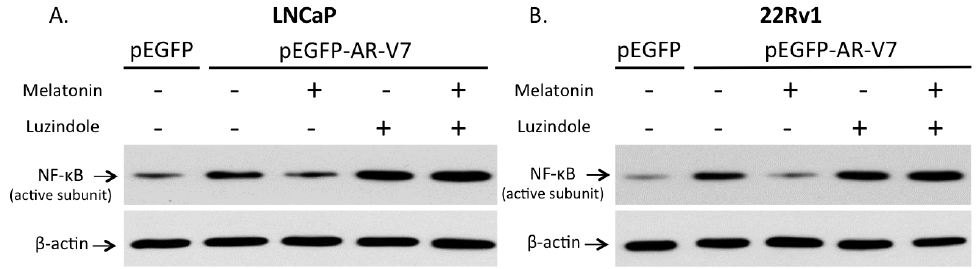
Figure 7. Effects of melatonin with or without luzindole on the expression of active subunit of NF- κ B in transfected prostate cancer cells. LNCaP ( A ) and 22Rv1 ( B ) cells were transfected with pEGFP, or pEGFP-AR-V7, in the presence or absence of 0.001% dimethylsulfoxide (DMSO), 10 − 6 M melatonin, 10 − 6 M luzindole, or 10 − 6 M melatonin plus 10 − 6 M luzindole. Immunoblot using an antibody against the active subunit of NF- κ B was carried out on protein lysates from transfected cells. β -actin was used as an internal control.